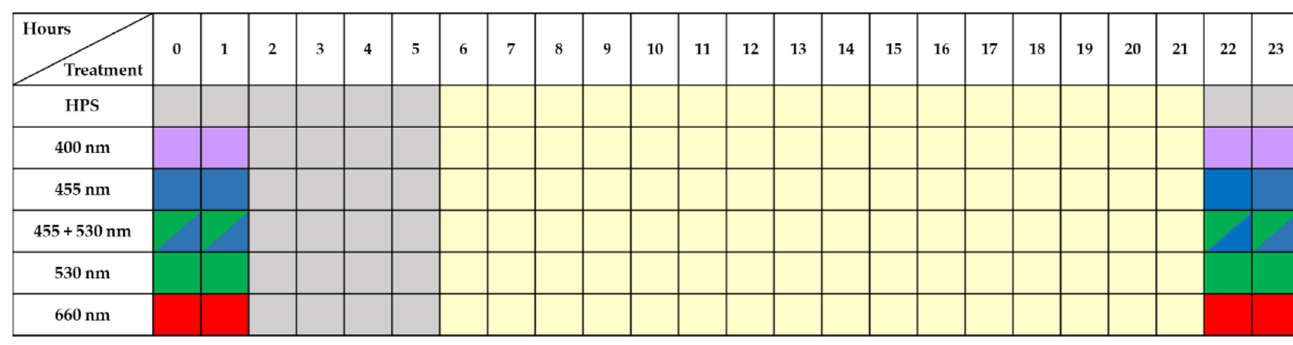
Figure 2. The lighting scheme of the 2nd experiment (EXP2).